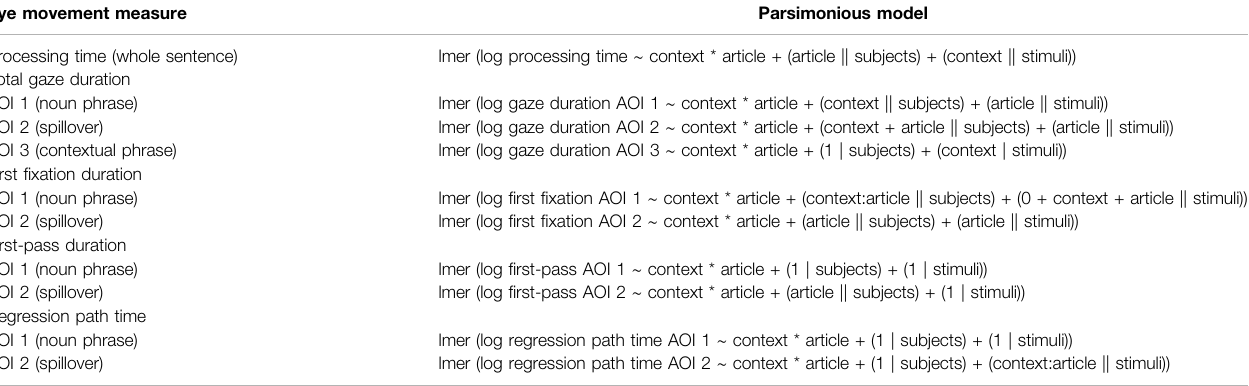
TABLE 3 | Parsimonious models selected for eye movements measures on the AOIs of Experiment 2. Eye movement measure